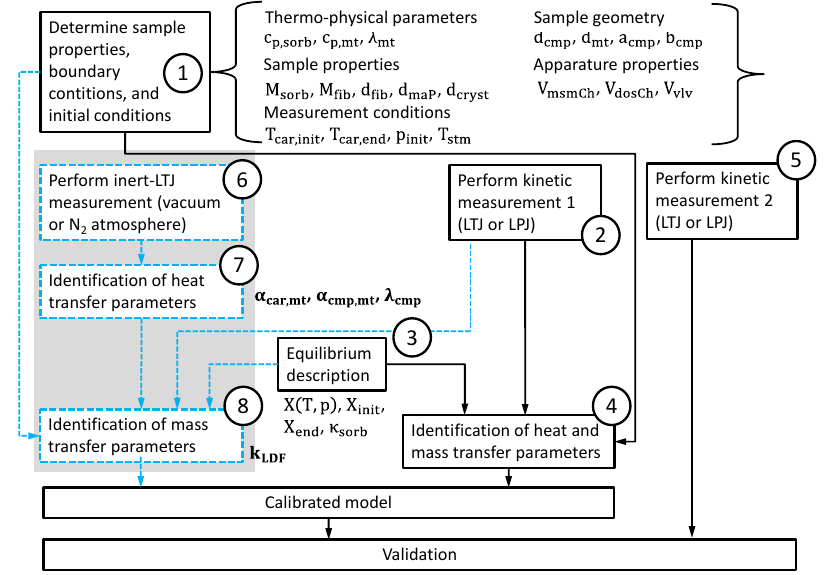
Figure 4. Measurement and simulation procedure; new elements are shown in blue color with dashed lines. The parameter sets are shown for a fibrous structure and a large temperature jump (LTJ) experiment. The parameters in bold print are unknown and have to be identified in the calibration procedure.